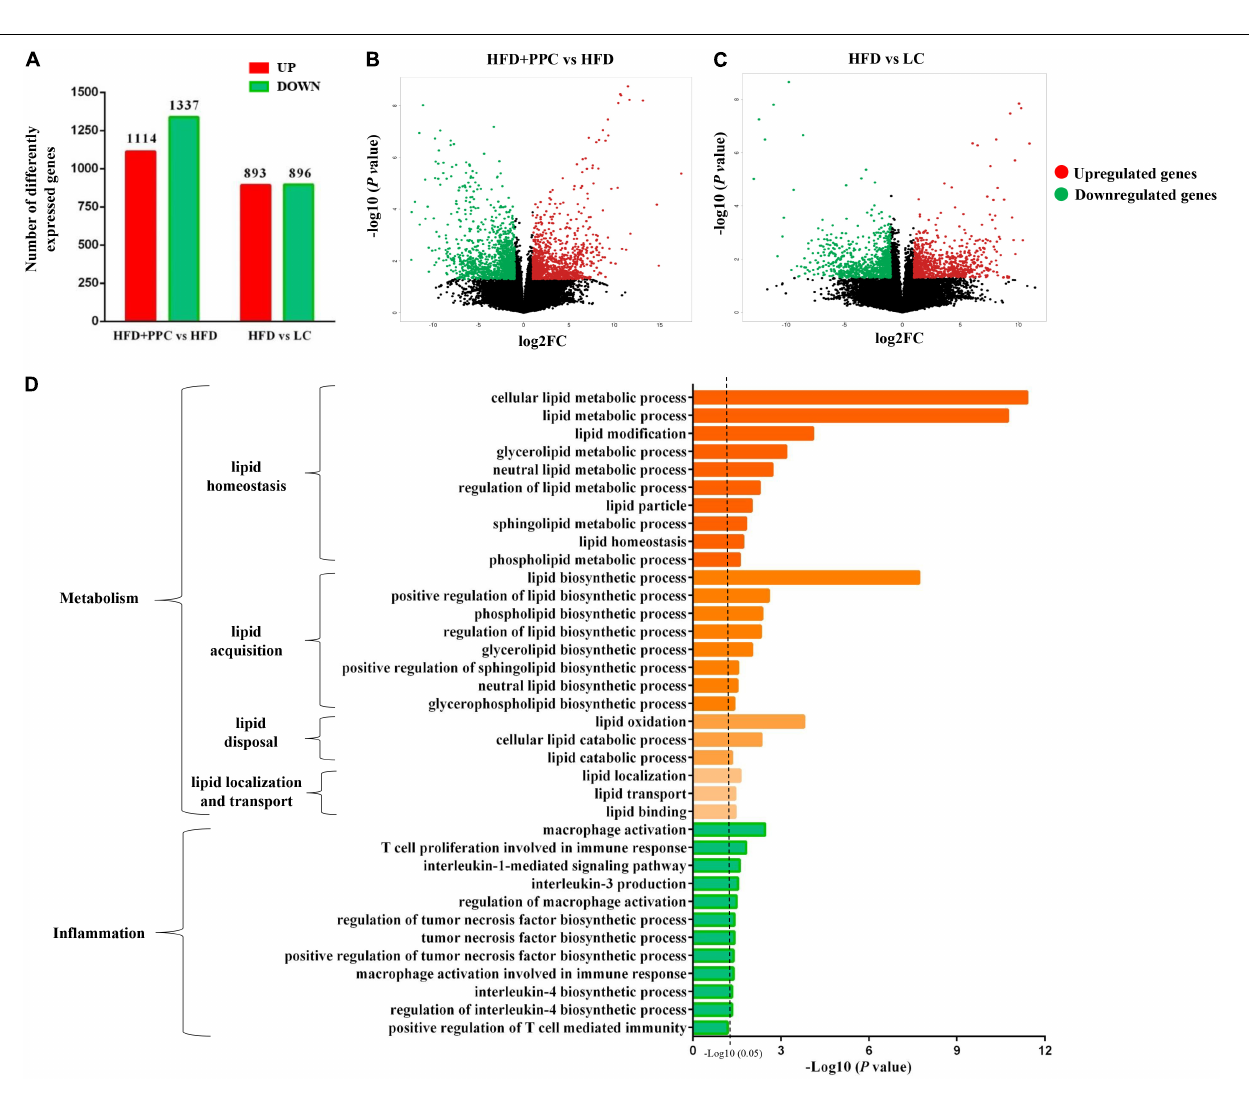
peroxisome proliferator-activated receptor alpha (Ppar- α ), and 5 (cid:48) -AMP-activated protein kinase (Ampk) ( Figure 5 ). These